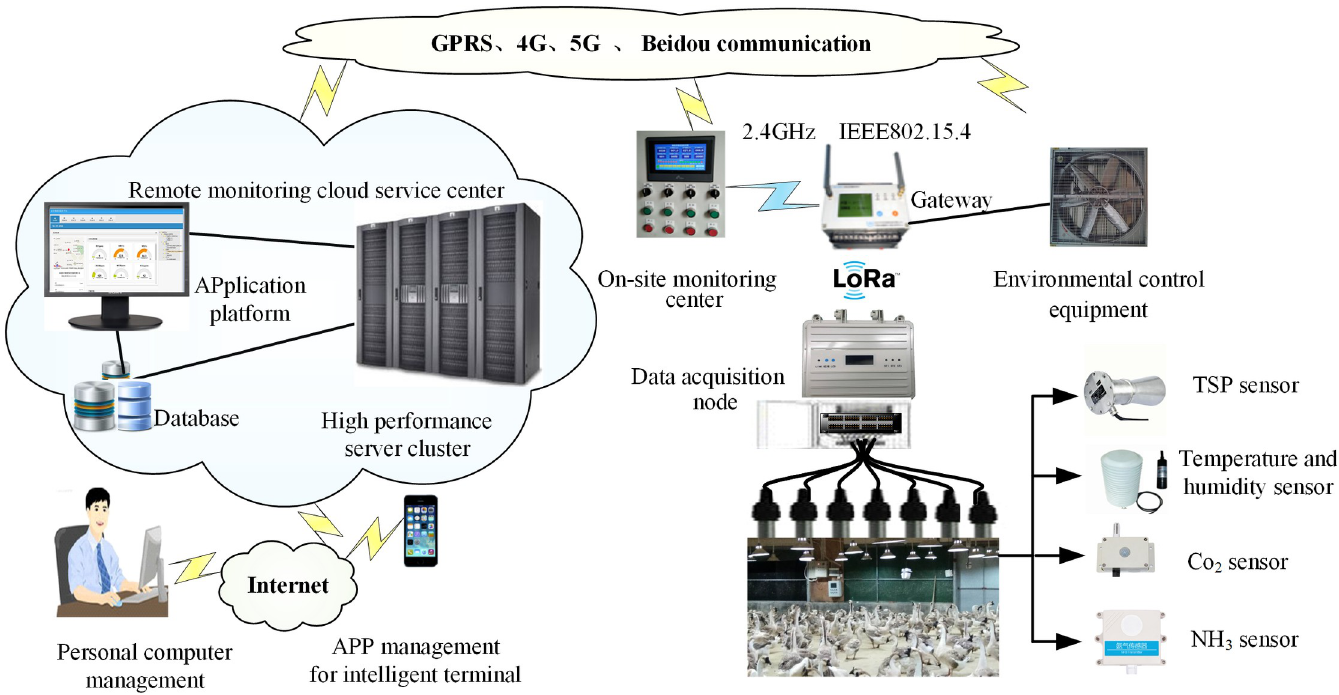
Fig 1. Schematic diagram of the waterfowl farm monitoring system based on the internet of things.